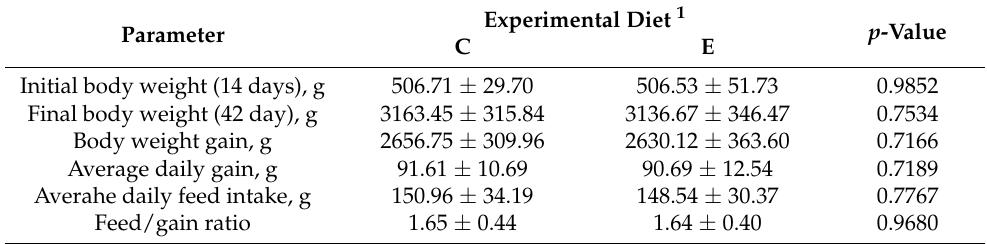
Table 3. Production parameters throughout the experimental period (1–42 days).